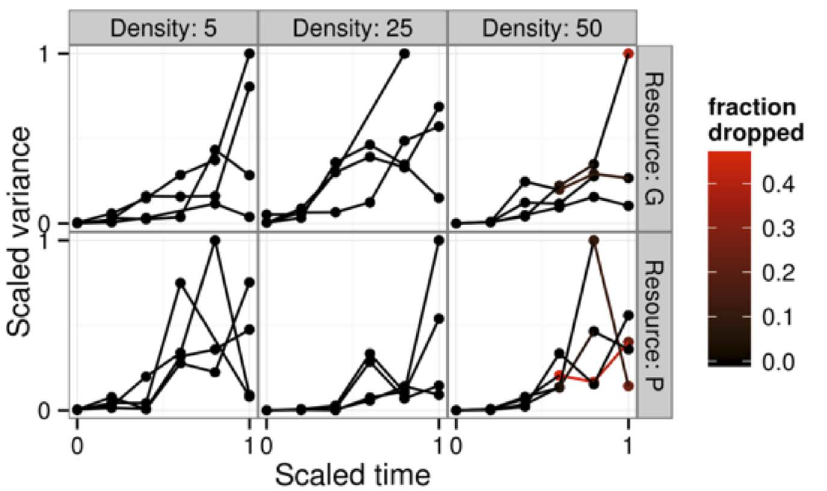
Figure 6. Estimated scaled variance per tank over time in different treatment combinations. Color scale represents the fraction of individual measurements dropped because they exceeded the estimated asymptotic size for the treatment combination (and hence could not be used in our linearizing transformation).